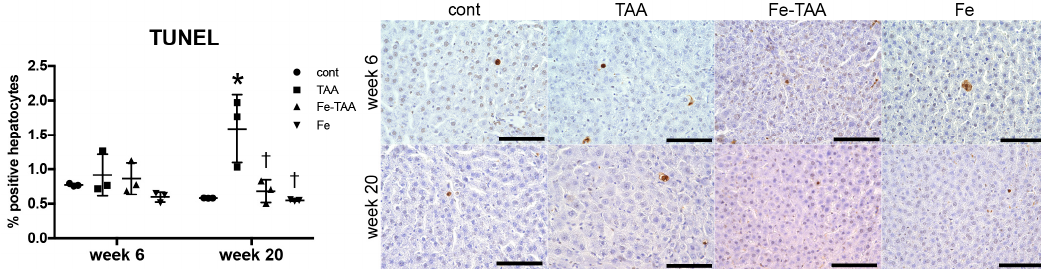
Figure 8. The number of TUNEL-positive (terminal deoxynucleotidyl transferase dUTP nick end labeling) hepatocytes (left) at weeks 6 and 20. * p < 0.05 vs. cont.; † vs. TAA; ‡ vs. Fe-TAA at the same time point, by Sidak’s multiple comparison. Representative images of TUNEL method (right) in the liver at weeks 6 and 20. Bar: 100 µm.